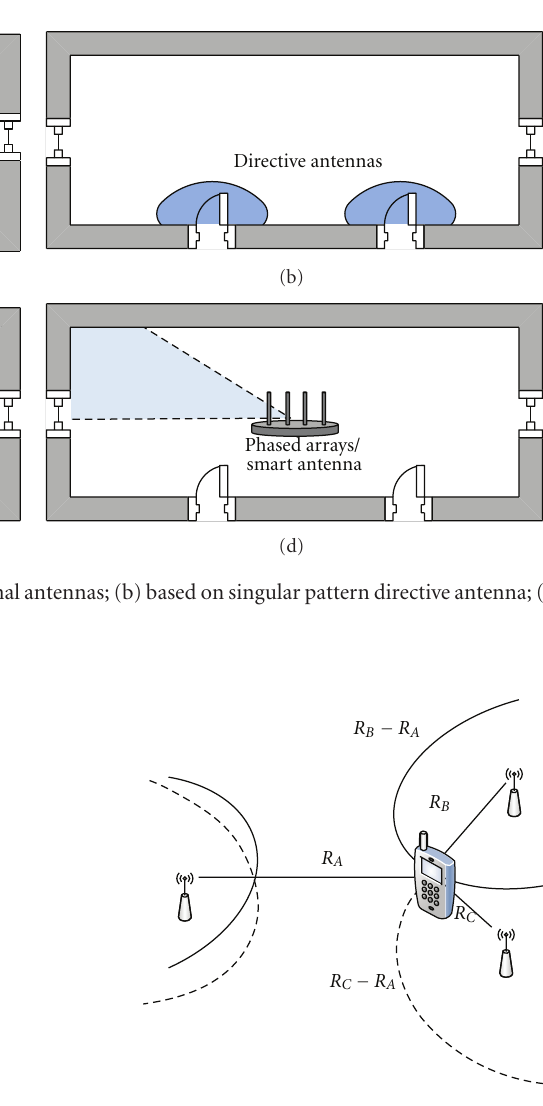
(ii) Di ff erence in the propagation time of multiple signals units.